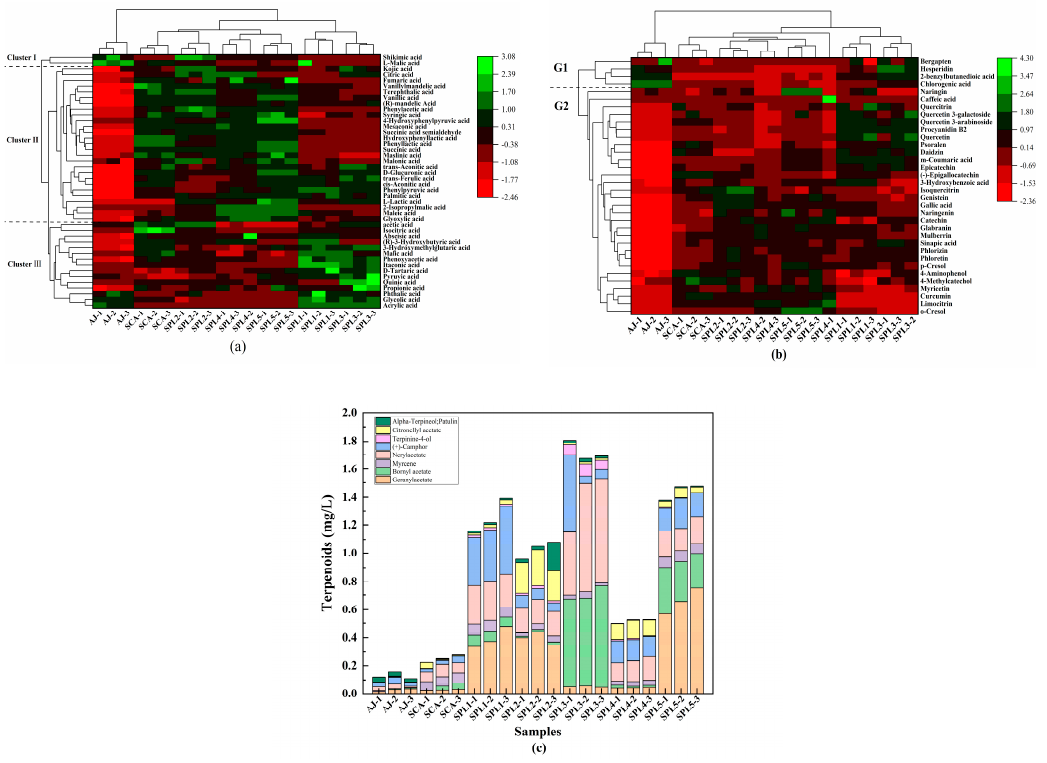
Figure 3. Compounds determined by LC-MS/MS in apple juice and ciders fermented using single- culture and triple mixed-cultures. Organic acids ( a ), polyphenols ( b ), and terpenoids ( c ). Polyphenols had a significant effect on both cider quality and health-promoting properties [41,42]. Previous studies revealed that apple ciders fermented with the cultures of non- Saccharomyces yeast and L. plantarum were rich in polyphenol contents and had higher antioxidant activities [26]. Among 86 detected compounds in this study, 34 poly- phenols were identified (Table 3). Moreover, polyphenol concentrations in AJ and SCA samples were lower than those in the triple mixed-culture fermented ciders; among them, SPL4 cider had the highest level of polyphenols (20.98 ± 5.24 μ g/L). According to the heatmap cluster analysis results in Figure 3b, there were significant differences in poly- phenol components of ciders fermented using different starters. Moreover, bergapten, hesperidin, 2-benzylbutanedioic acid, and chlorogenic acid clustered into one group (G1). Cluster G2 included 30 phenol compounds; among them, caffeic acid, epicatechin, gallic acid, naringenin, glabranin, phlorizin, and phloretin were found in higher levels in the triple mixed-culture fermented ciders than in the AJ and SCA samples. Hence, the triple mixed-cultures enhanced the formation of many polyphenol compounds, improving the comprehensive quality of apple ciders. The triple mixed-cultures had significant effects on terpenoids in apple ciders (Table 3, Figure 3c). The addition of P. kudriavzevii and L. plantarum significantly increased the total amount of terpenoids in apple ciders (from 514.96 ± 11.86 μ g/L to 1661.52 ± 48.05 μ g/L), especially in SPL3 cider (1661.52 ± 48.05 μ g/L), which was about 7-fold higher than that determined in the cider from the single-culture of S. cerevisiae (SCA) (231.69 ± 15.56 μ g/L).